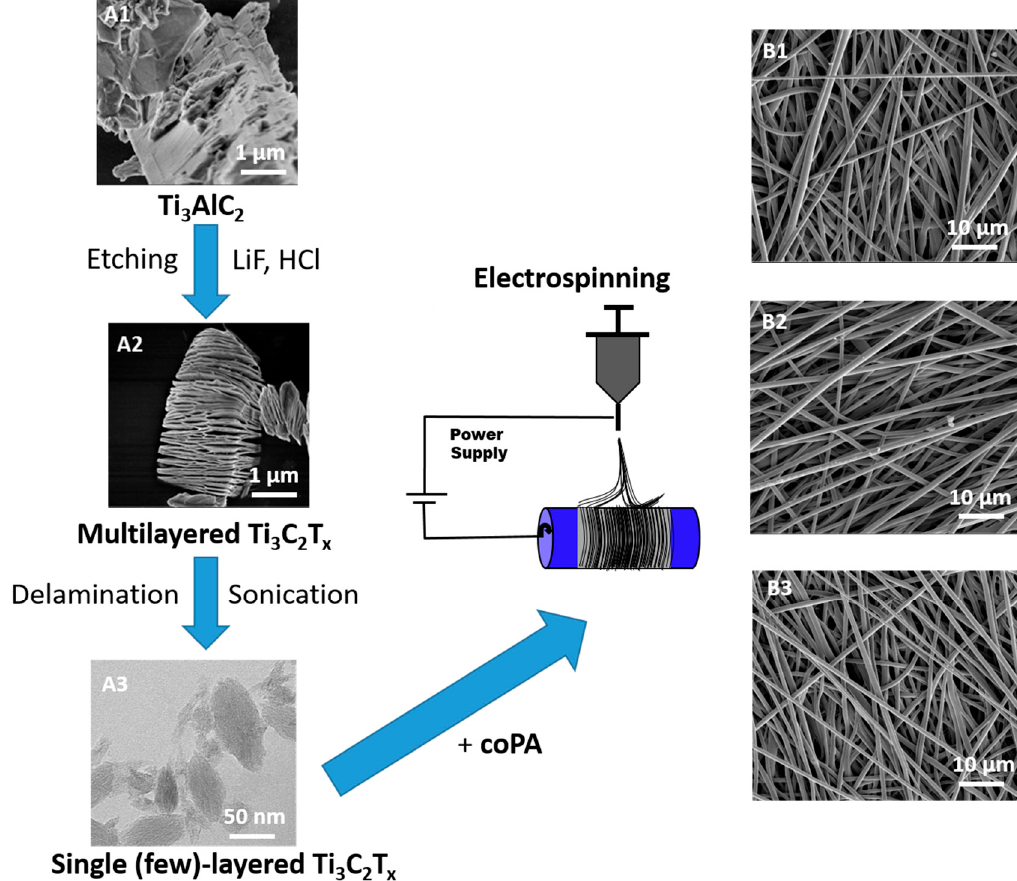
Figure 1. Preparation route of Ti 3 C 2 T x and SEM images of precursor (A1), multilayered Ti 3 C 2 T x (A2), and single (few)-layer Ti 3 C 2 T x . (B1) neat coPA, (B2) coPA and 2.5 wt.% of Ti 3 C 2 T x , and (B3) coPA and 5 wt.% of Ti 3 C 2 T x .